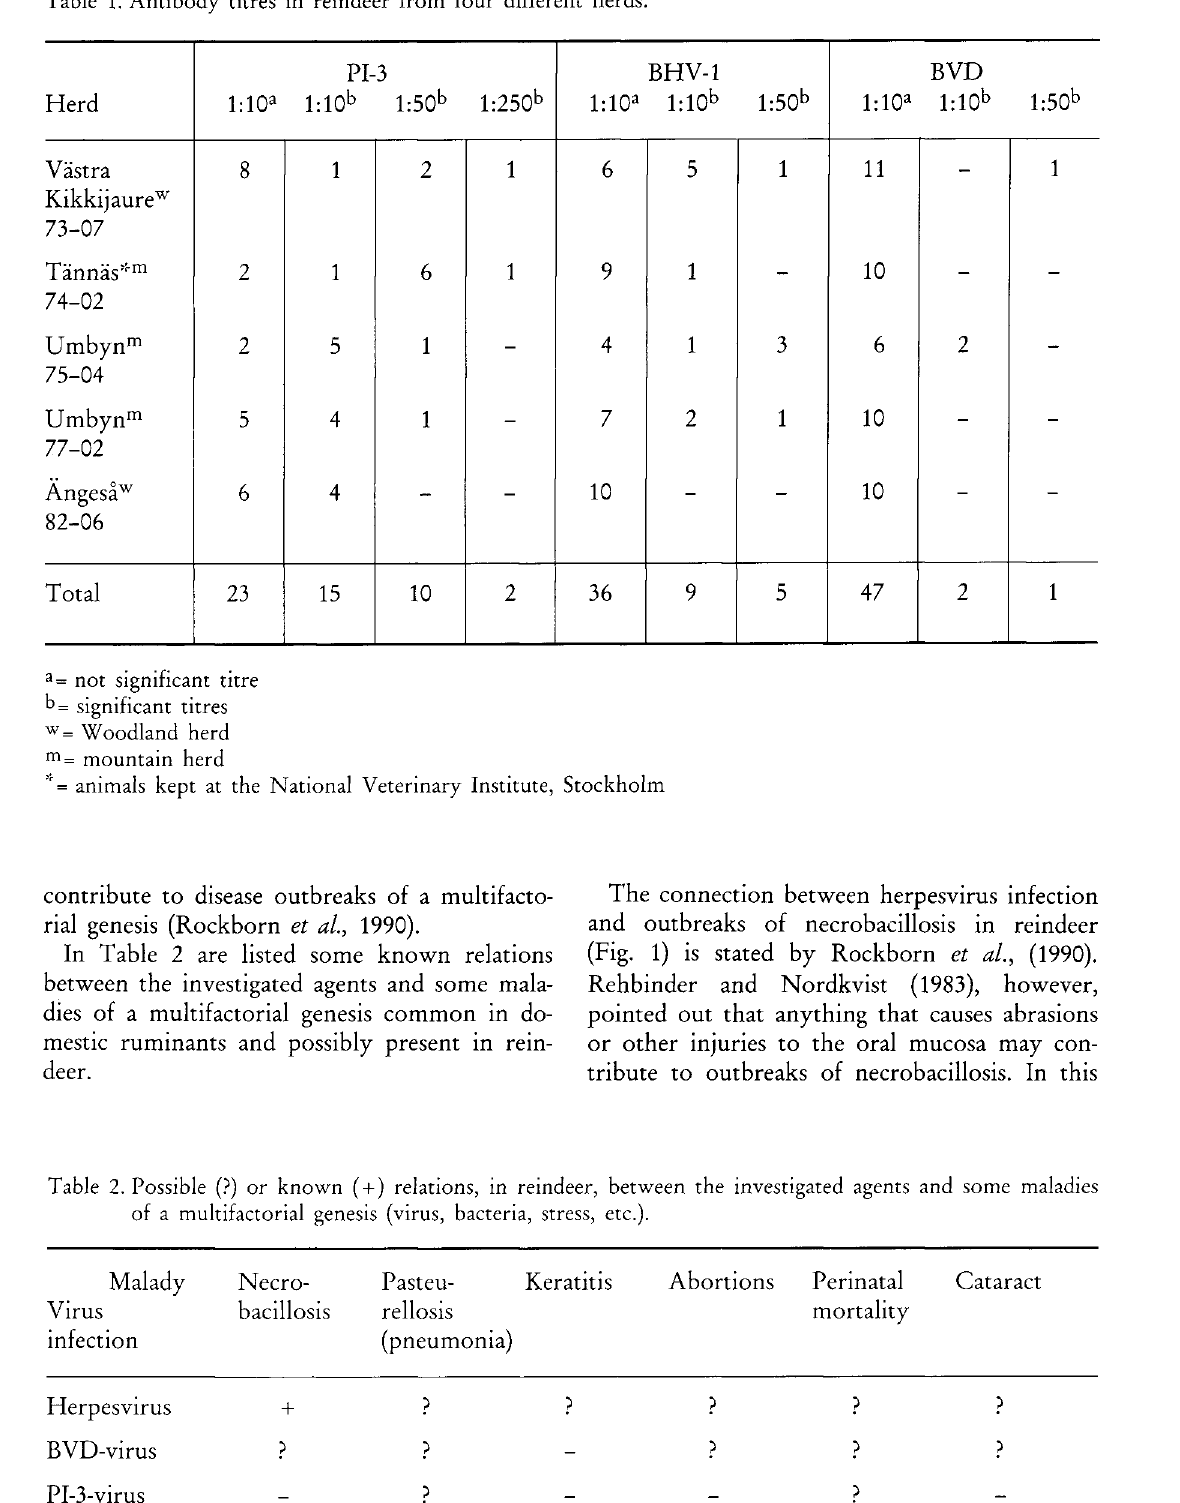
Table 1. Antibody titres in reindeer from four different herds.